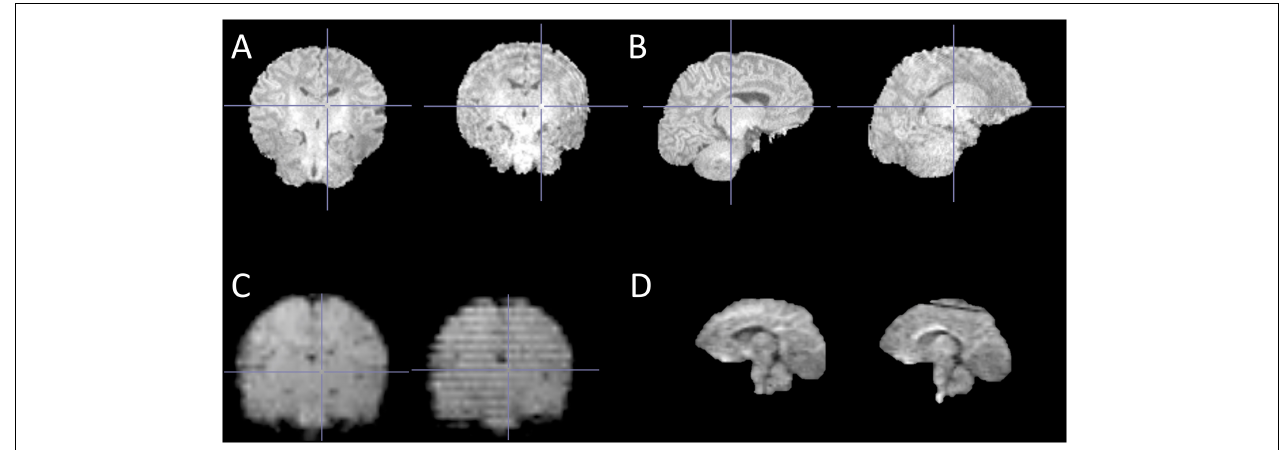
FIGURE 2 | Representative examples of successful and unsuccessful neonate MRI scans (randomly selected from our data). (A) T1-weighted structural image with no motion artifacts (left) and with typical “ringing” motion artifact (right); (B) same images as in A in sagittal view; (C) fMRI images with no motion artifacts (left) and with typical “striping” motion artifact (right); and (D) diffusion-weighted image with no motion artifacts (left) and a typical “loss of signal” artifact at the superior part of the image (right). Of note, these examples are not exhaustive and are provided for visualization purposes